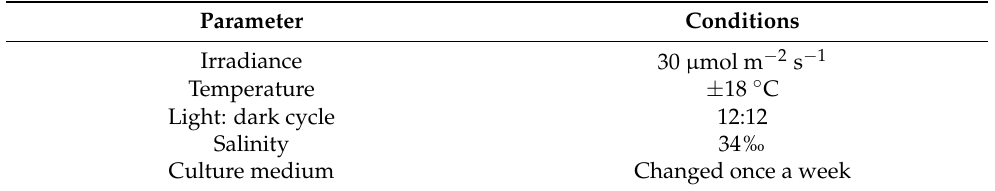
Table 1. Culture chamber